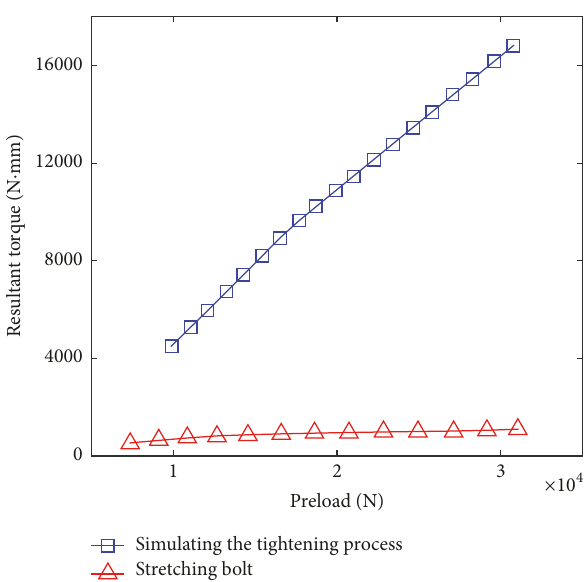
Figure 13: The relationships between the torque and the